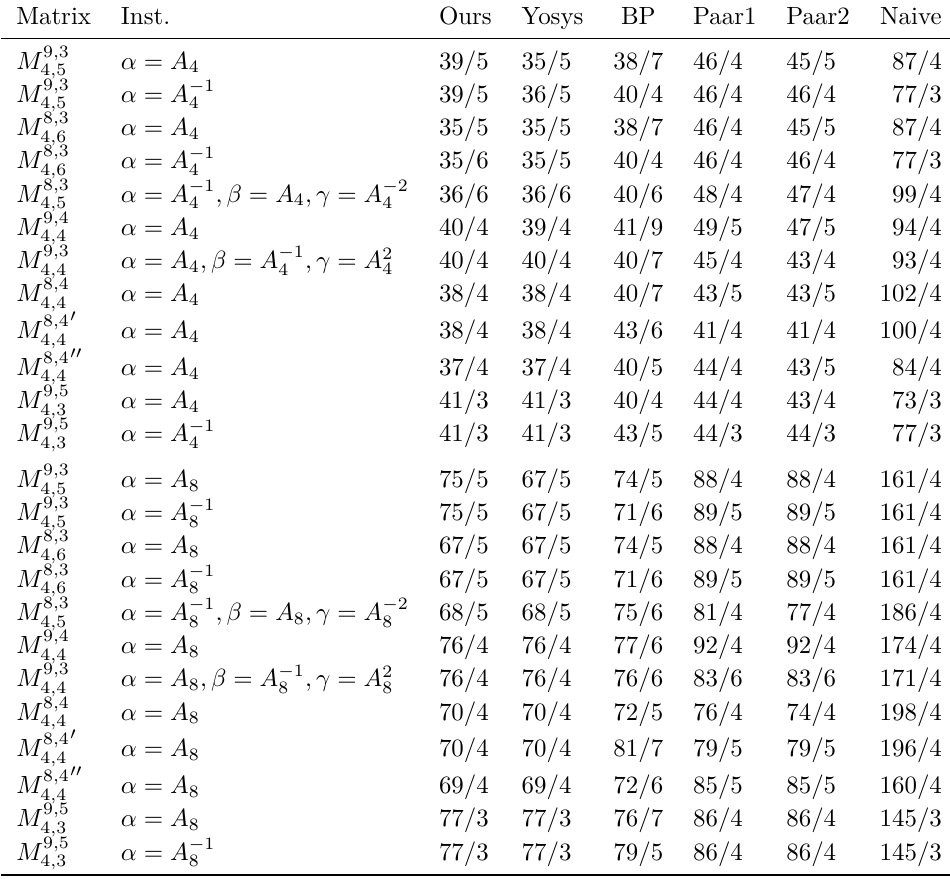
Table 5: Instantiation of some of our results, and comparison of our circuit with several optimization tools: Yosys (starting from our circuit), and the heuristics from [BP10] and [Paa97] (starting from the matrix, limited to 3 hours). We show the xor count and the implementation depth. We adapted the code from [KLSW17] to run those tests. Matrix